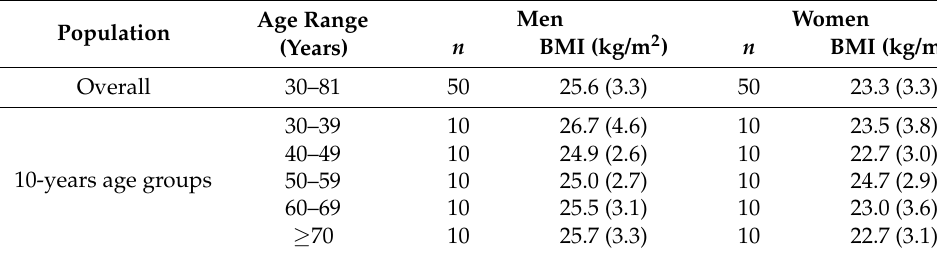
Table 2. Characteristics of individuals included in the study.